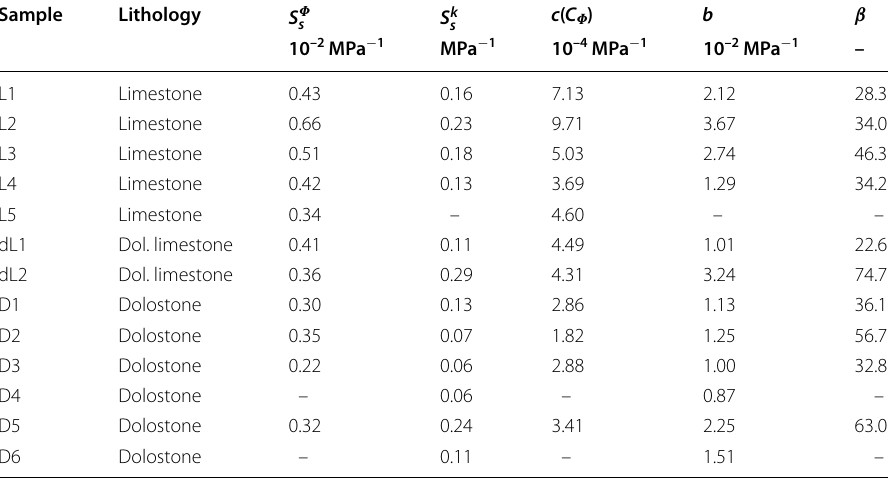
Table 5 Effective stress sensitivity coefficients of the tested rock samples at an effective pressure of 28